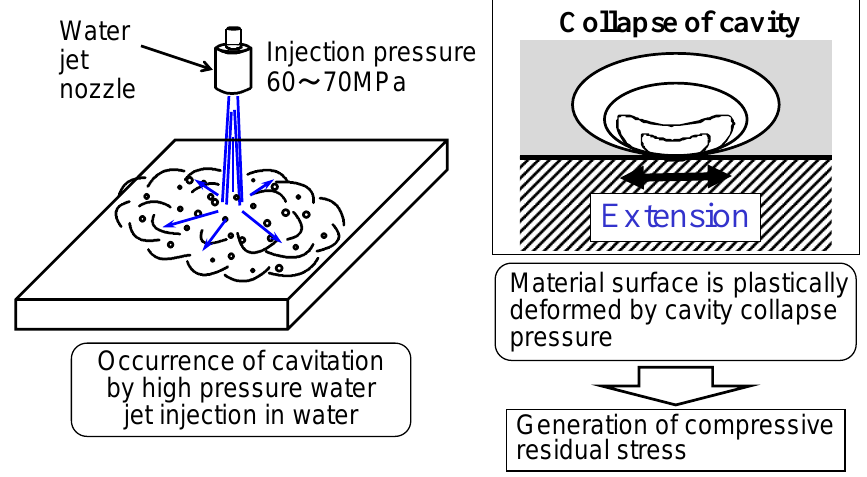
Figure 1. Principle of water jet peening.